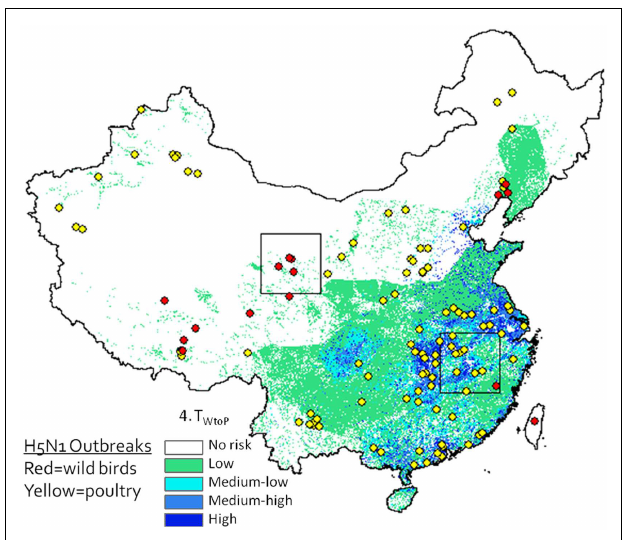
FIGURE 6 | H5N1 outbreak data (2003–2009) plotted against Level 2 deterministic 1km resolution H5N1 transmission risk models (Eq. 4) . Wild bird cases shown by red circles, poultry by yellow circles. Although spatial associations between outbreak data and risk map appear to be high, since the model is intended to predict risk at the interface between poultry and waterfowl, this type of presentation may be misleading as it is not known whether yellow dots represent poultry cases caused by transmission from wild birds (versus poultry) and whether red dots represent wild bird cases caused by poultry (versus wild